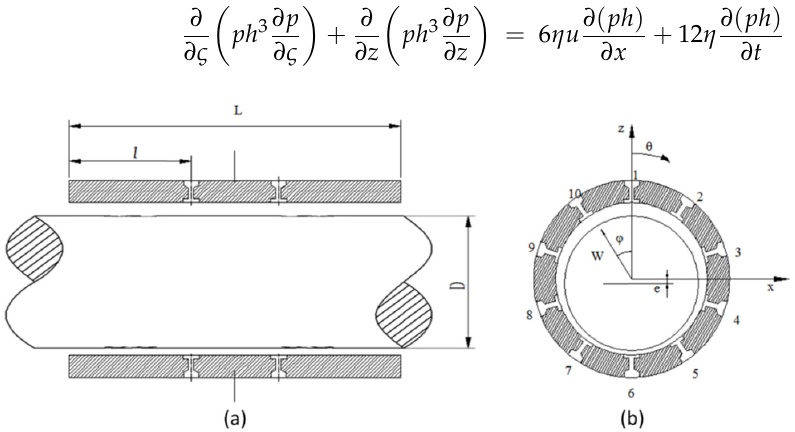
Figure 1. Schematic diagram of hybrid air bearings ( a ) axial direction, ( b ) circumferential direc ‐ tion.